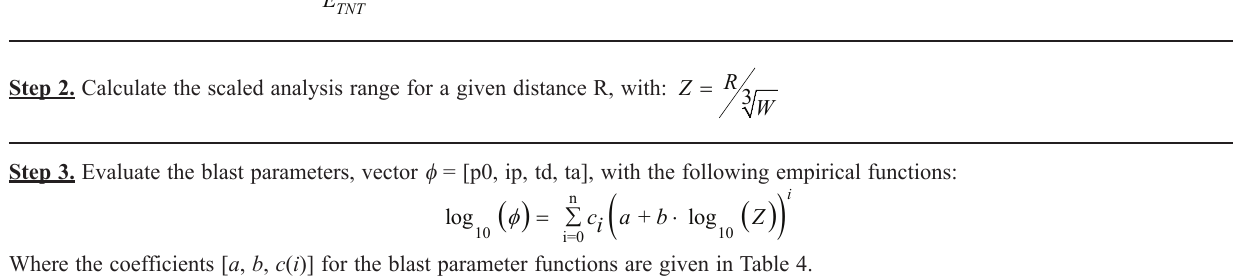
Step 1. Calculate W ,